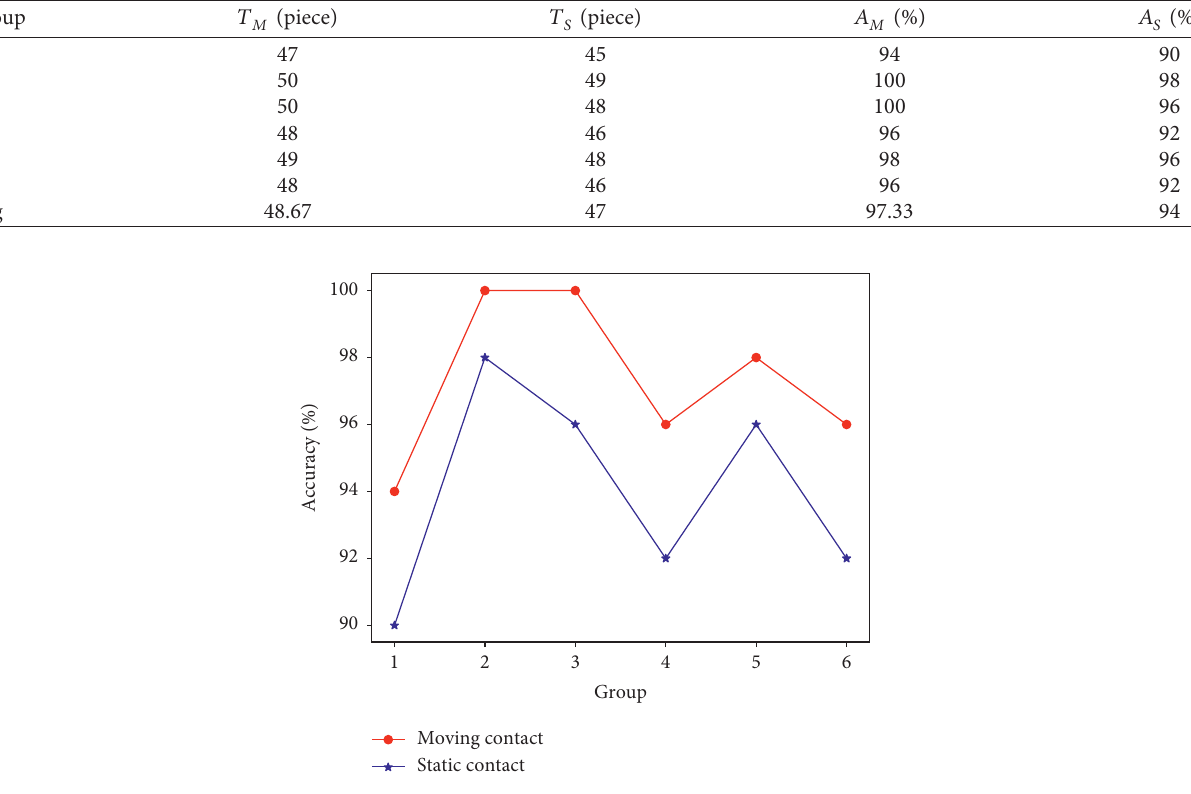
Table 2: The DLM positioning result data.